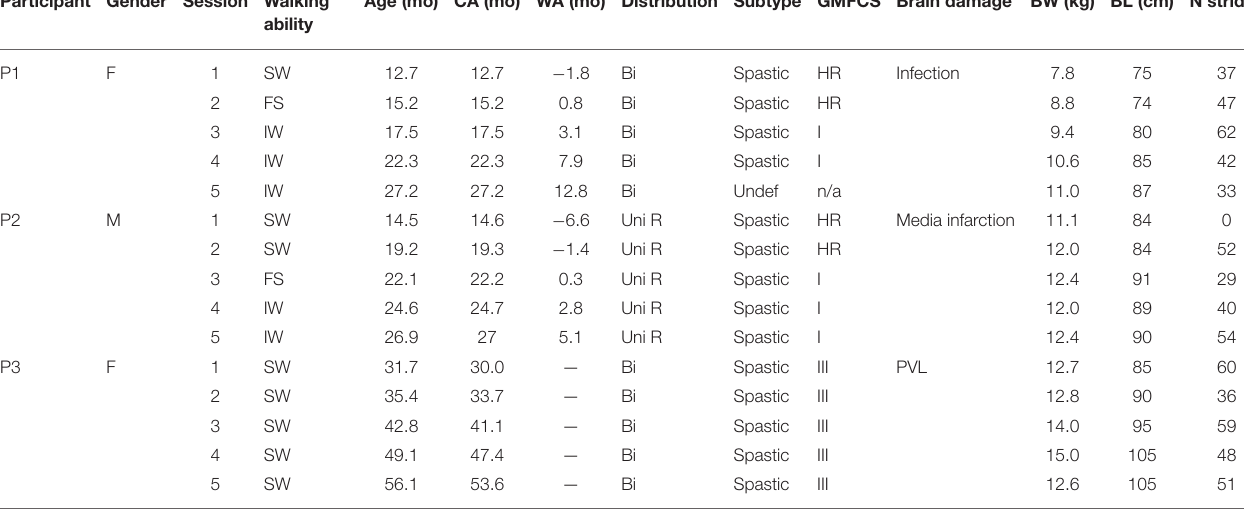
TABLE 1 | Participant characteristics. Participant Gender Session Walking